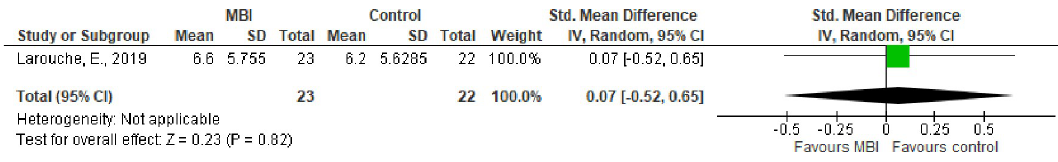
Fig 6. Forest plot of comparison: Depressive symptoms, MBI versus control after 11 weeks to 6 months from the beginning of the intervention.